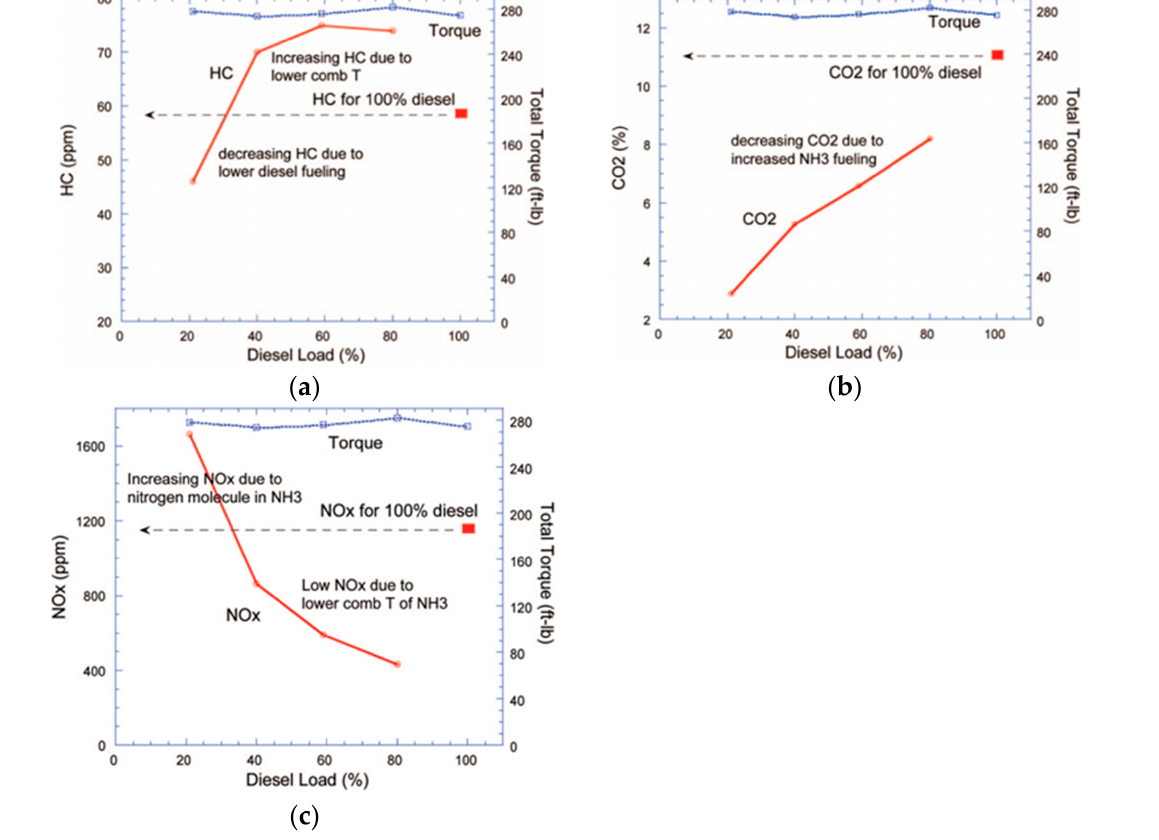
Figure 10. Effect of different ammonia doping ratios on emissions: ( a ) HC emissions; ( b ) CO 2 emissions; ( c ) NOx emissions.